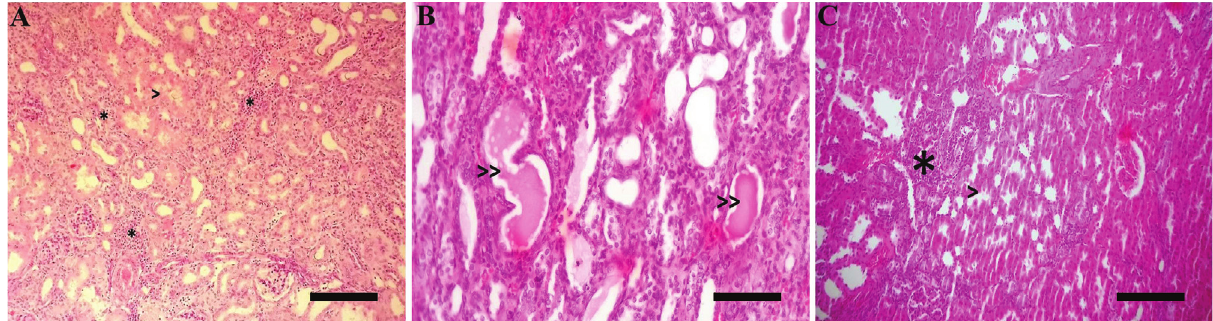
Figure 5 - Histological sections of the kidneys from cisplatin treated and MSC transplanted animals. A) Hydropic degeneration (>) and interstitial infil- tration (*); scale bar: 100 (cid:2) m. B) Intratubular cast formation (>>); scale bar: 25 (cid:2) m. C) interstitial fibrosis (>) and interstitial infiltration (*); scale bar: 100 (cid:2)